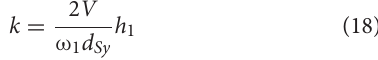
From Eqs. (15) and (17), the stiffness ratio k of DSA to the main frame can be expressed in terms of h 1 of the viscous